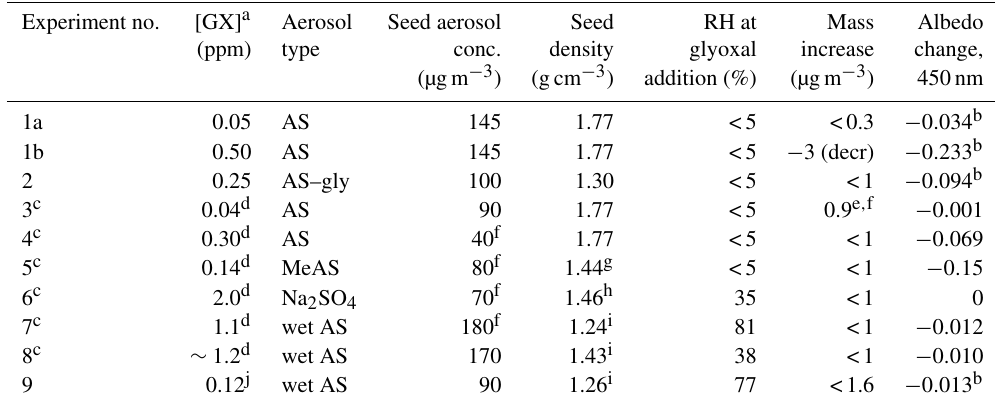
Table 1. Summary of glyoxal gas addition experiments. Experiment no. [GX] a Aerosol Seed aerosol Seed RH at Mass Albedo (ppm) type conc. density glyoxal increase change, (µgm − 3 ) (gcm − 3 ) addition (%) (µgm − 3 ) 450nm 0.05 AS 145 1.77 145